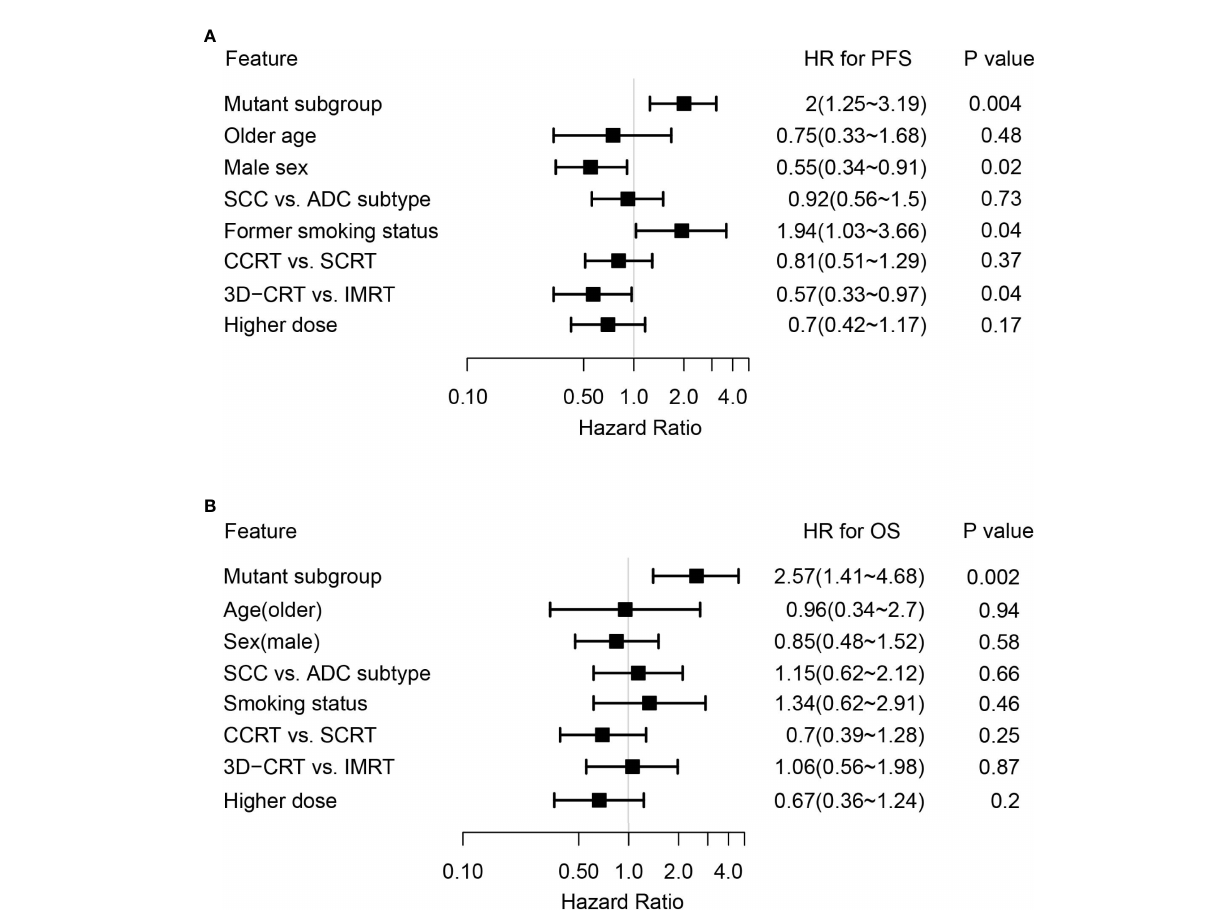
FIGURE 6 | Multivariate Cox analysis of clinical features associated with survival outcomes in the genetically altered subgroup. (A, B) Forest plots showing the mutant subgroup and all relevant clinical features in association with (A) PFS and (B) OS following dCRT treatment by multivariate analysis. Mutant subgroup: patients with any of the MET , NOTCH2 and PTEN loss of function, as well as FGFR and KEAP1-NRF2 pathway gene alterations; ADC: adenocarcinoma; SCC: squamous cell